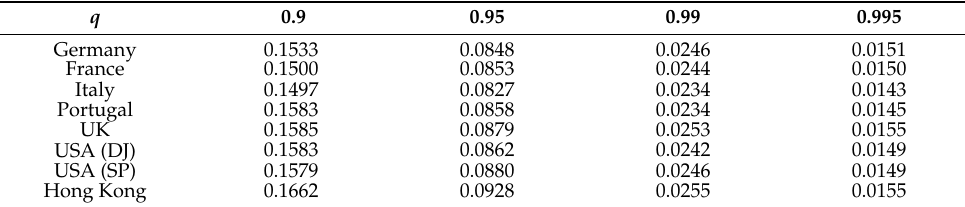
Table 6. Values of 1 − (cid:98) C B ( q , q ) for Spain and the countries